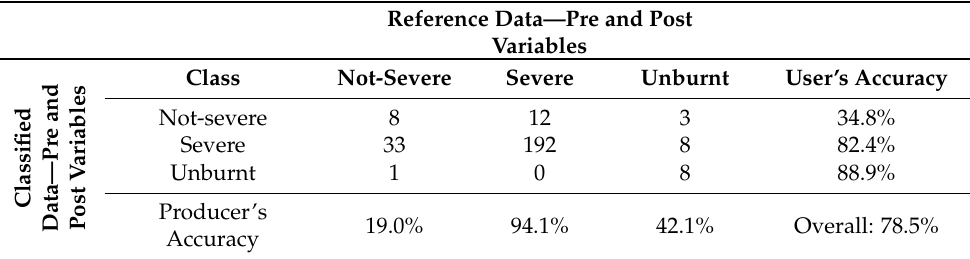
Table 13. Confusion matrix for combined stream describing severity of forest